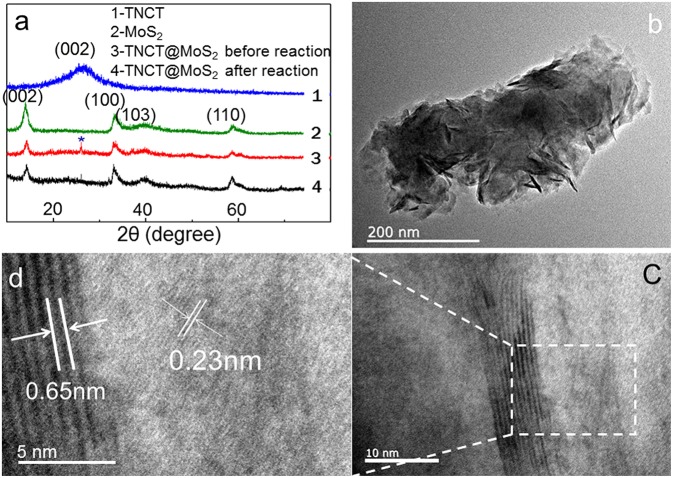
XRD (a), HRTEM (b–d) patterns of TNCT@MoS2. * indicates the (002) crystal plane of TNCT.